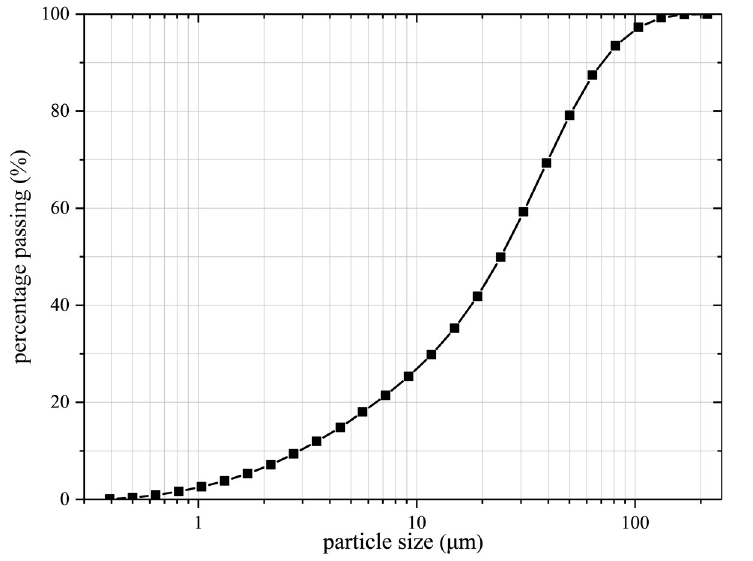
Fig 2. Granular gradation curve of loess.